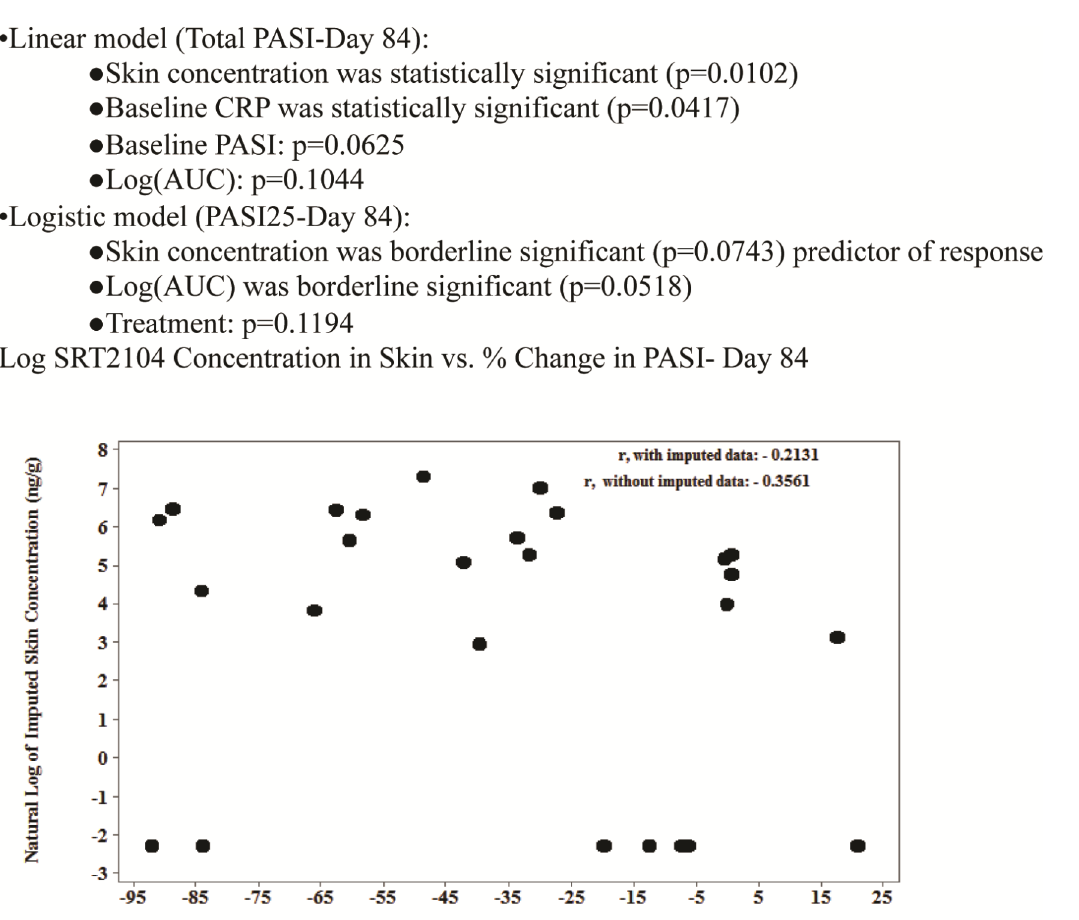
Fig 3. Post-hoc Exploratory Analyses of Predictors of